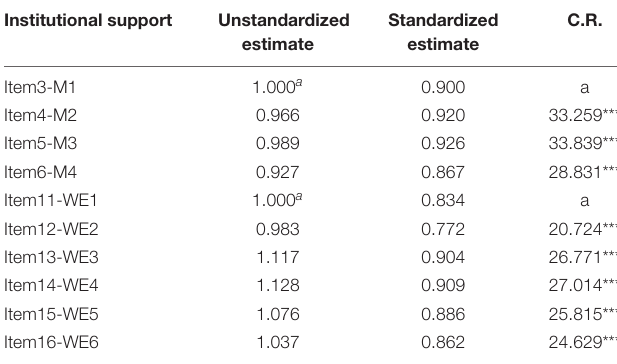
TABLE 4 | CFA regression weights for the two-factor correlated model of institutional support.